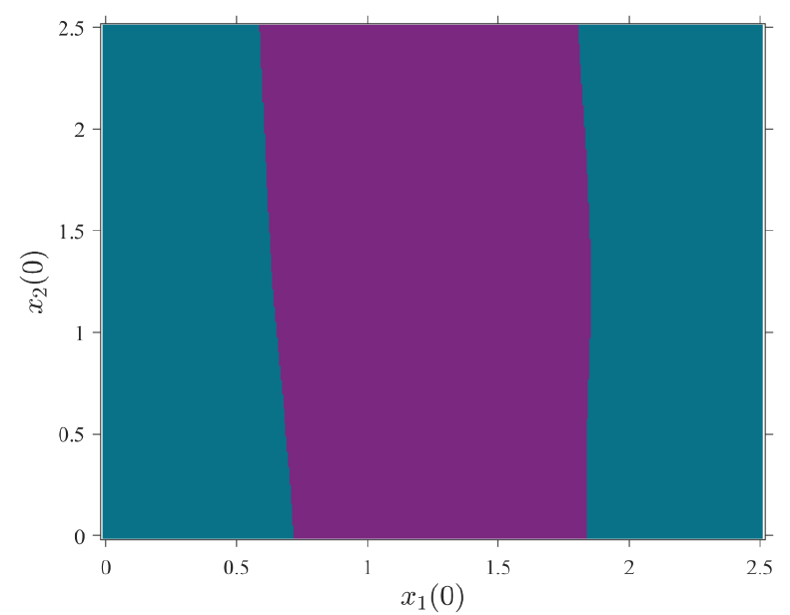
Figure 9. Basin of attraction of two 3D-MCMs in the x 1 - x 2 plane for ( y 1 ( 0 ) , φ 1 ( 0 )) = ( 0.8, 0.2 ) and ( y (0), 𝜙 (0)) = (0.2, 0.3) . Purple region: chaotic oscillation; blue region: quiescent. The system parameters are set as mentioned in Table